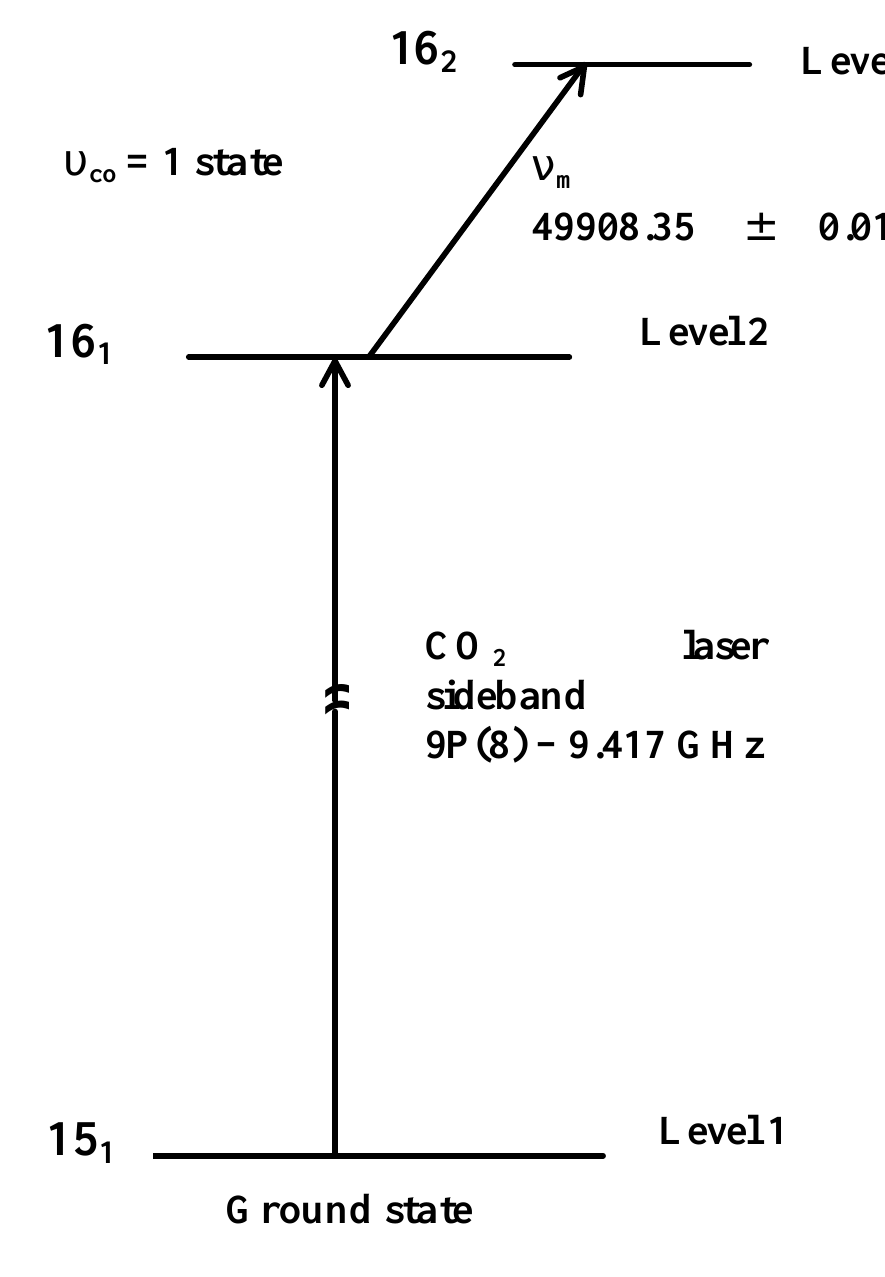
Figure 2. Energy levels relevant to the signal shown in Figure